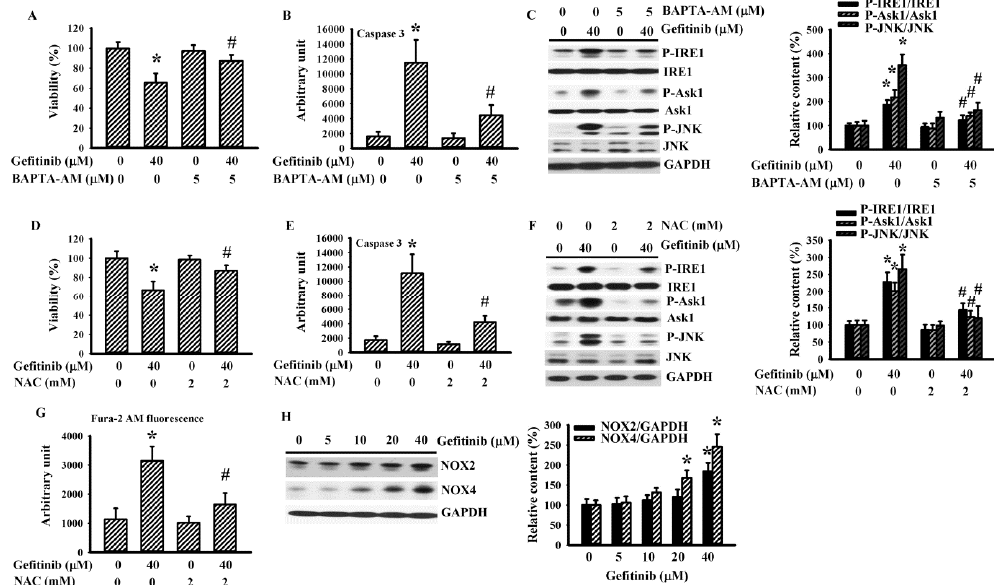
Figure 4. BAPTA-AM and NAC alleviated gefitinib-induced apoptosis in H4 cells. H4 cells were treated with gefitinib (0 and 40 μM) together, with or without BAPTA-AM (5 μM, A – C ), or NAC (2 mM, D – G ). Cell viability (24 h) was measured with the alamarBlue assay ( A , D ). Caspase 3 activity (6 h) was measured with enzymatic assay ( B , E ). Protein extracts (6 h) were subjected to Western blot with indicated antibodies. Representative blots of three independent experiments and quantitative data are shown ( C , F ). Intracellular free Ca 2+ (6 h) was measured with Fura-2 AM fluorescence ( G ). H4 cells were treated with various concentrations of gefitinib (0–40 μM). Protein extracts (6 h) were subjected to Western blot with indicated antibodies. Representative blots of three independent experiments and quantitative data are shown ( H ). Protein contents were normalized with corresponding total protein or GAPDH. * p < 0.05 vs. untreated control and # p < 0.05 vs. gefitinib (40 μM), n = 4 ( A , B , D , E , G ).